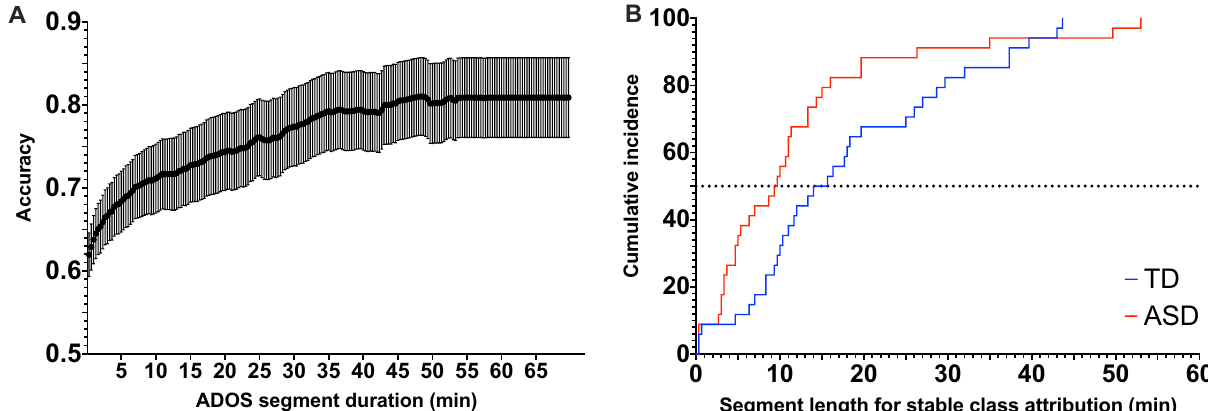
Figure 3. ( A ) Association between the prediction accuracy and the length of considered video segment. The accuracy increases with longer video segments, with the final accuracy being 81% for Testing set 1 in our sample. ( B ) Stability in the prediction as a function of the length of the considered video segment for the Testing set 1. The cumulative incidence depicts the required length of video segments that is needed to achieve 100% prediction consistency for all the segments of the same length randomly drawn from the full video of the same participant.